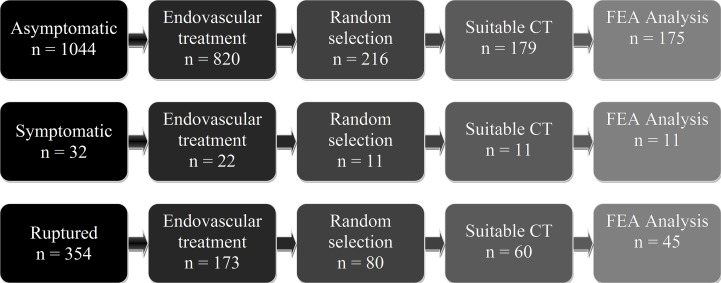
Flowchart patient selection.